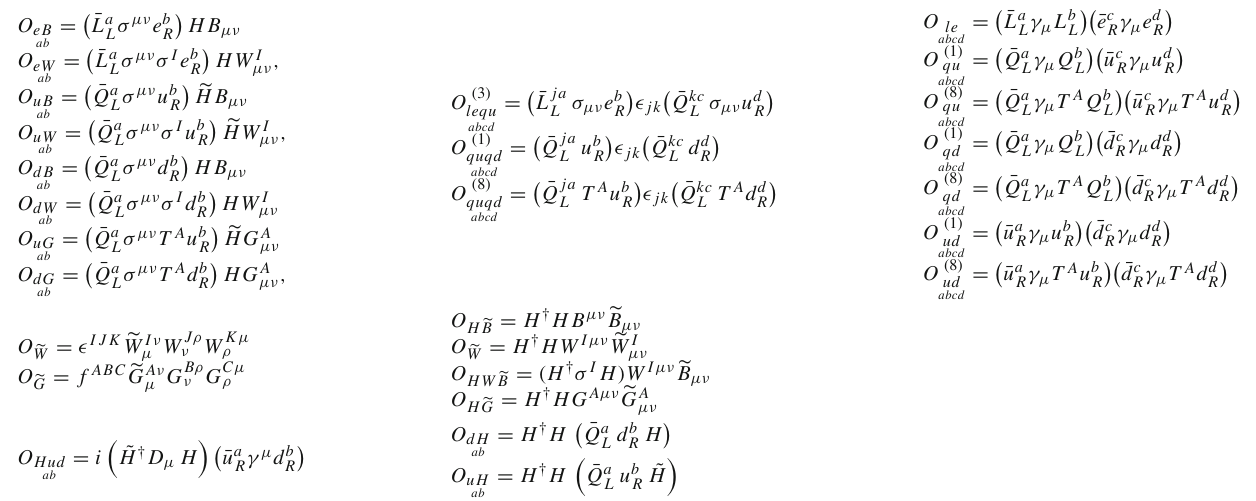
ators O (3) and O (1,8) we show SU(2) indices j , k explicitly. For the lequ quqd ( 1 , 8 ) as well as the ψ 2 H 3 vector operators in the 4-fermion class the only CP violation can arise ud if flavors of the fermions in each current are not identical, hence